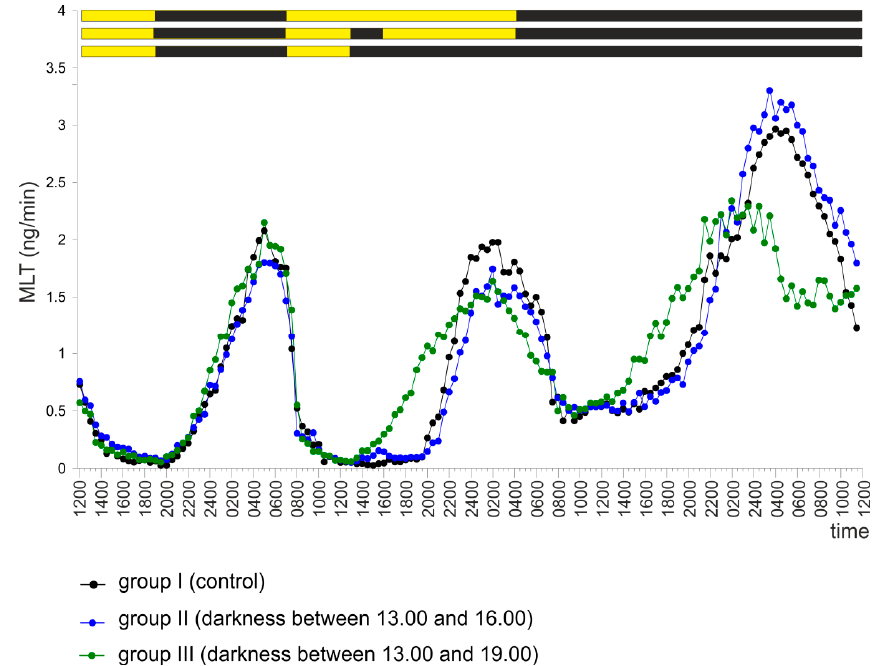
Figure 7. Experiment IV. Secretion of MLT (mean) from turkey pineal organs incubated under a 12 L:12 D cycle during the first two days of the experiment and then in continuous darkness for one day. The pineal organs from groups II and III were incubated in darkness between 13.00 and 16.00 (group II) or between 13.00 and 19.00 (group III) during the second day of the experiment. Group I (control)